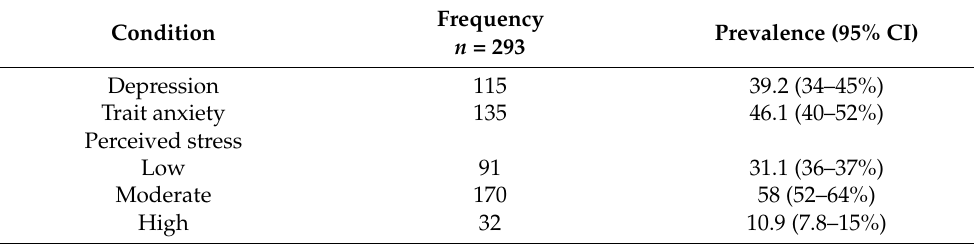
Table 3. Prevalence of depression, trait anxiety, and perceived